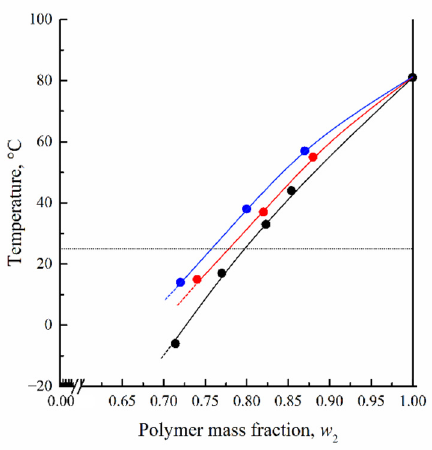
compositions. The mass fraction of the polymer in the mixture is indicated to the right of the curves.